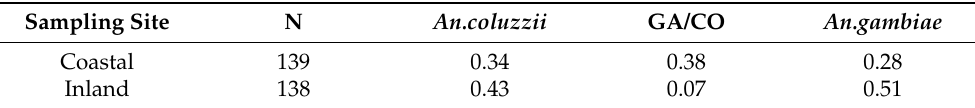
Table 1. Frequency of IGS- An. coluzzii, IGS- An. gambiae and IGS-hybrids (GA/CO) in a coastal (Ayame) and in an inland (Petessou) village in Cote d’Ivoire. N = number of specimens identified by IGS markers [14].